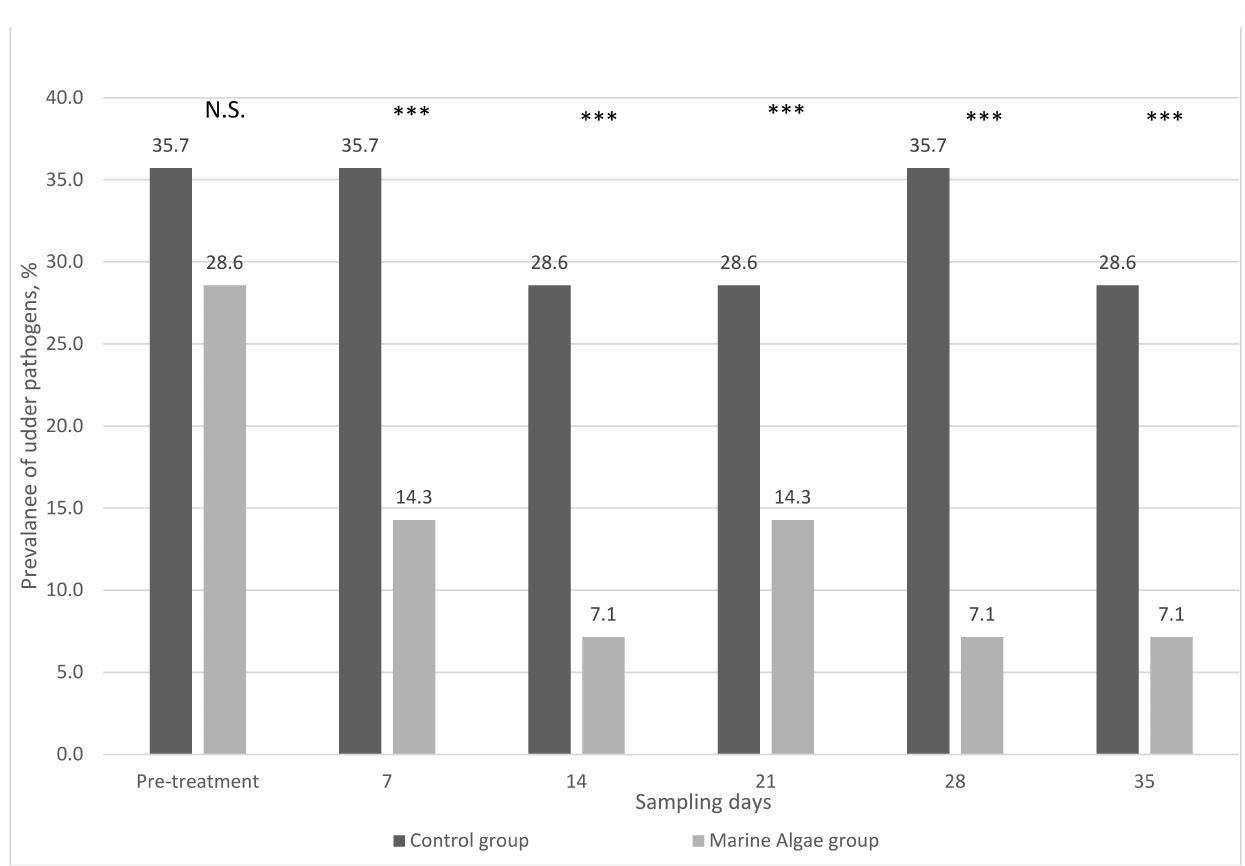
Figure 2. Prevalence of udder pathogens from different feeding treatments (each group and sampling day n = 14). N.S.—not significant; ***— p <